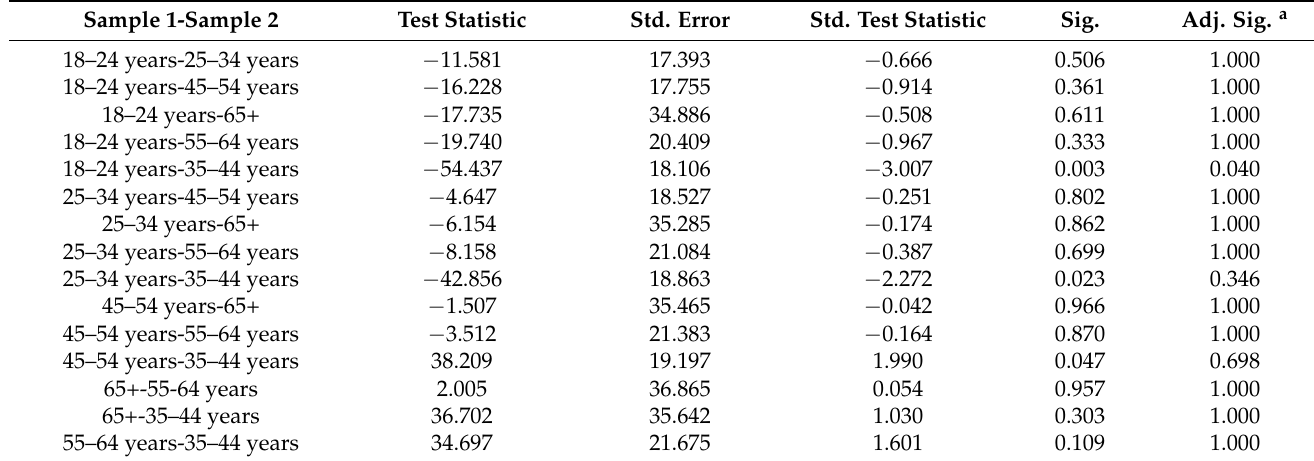
Table 8. Post hoc analysis—art fraud and forgery.